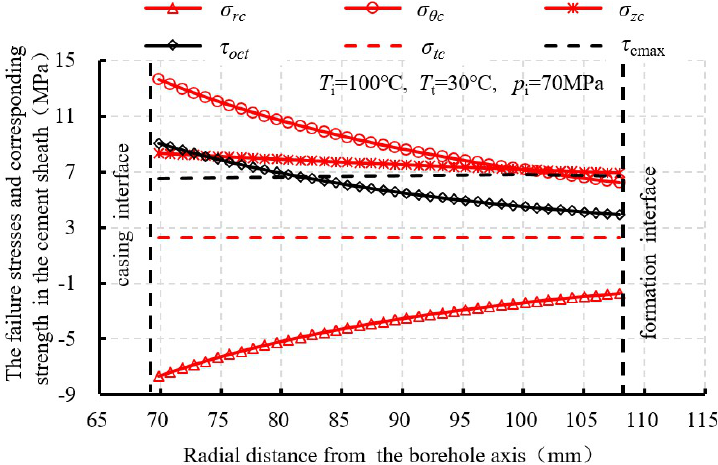
Figure 13. Radial distribution of the failure stress and corresponding strength of the cement sheath under only a decreased temperature of 70 °C at the casing inner wall.